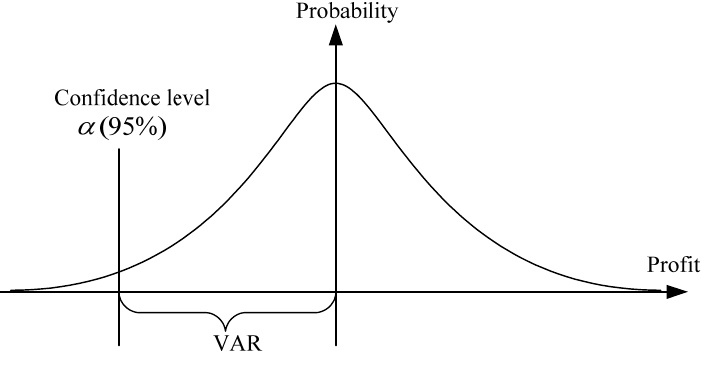
Figure 2. The diagram of VAR calculation.